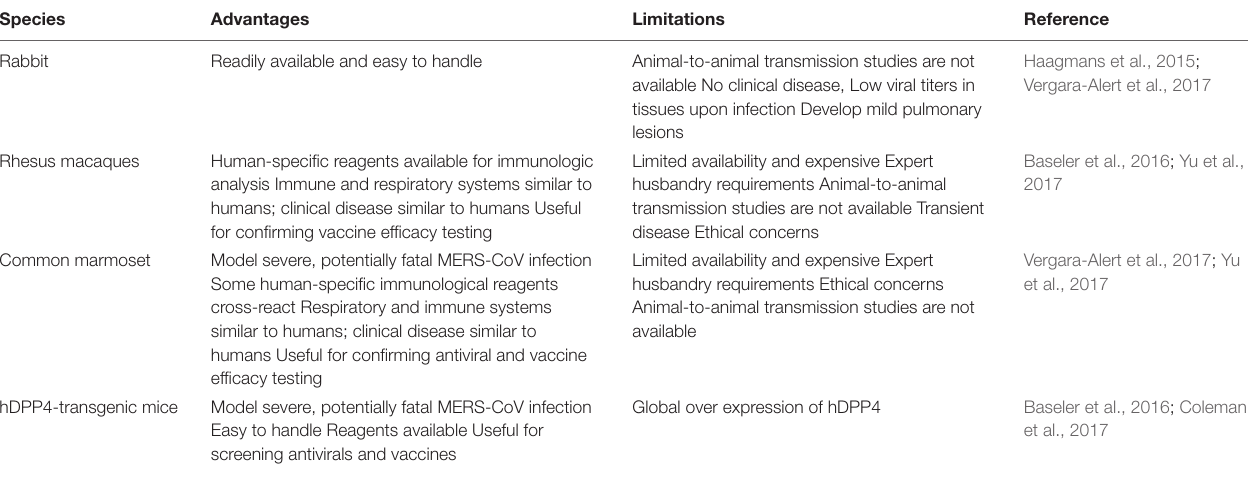
TABLE 2 | Advantages and limitations of MERS-CoV experimental animal